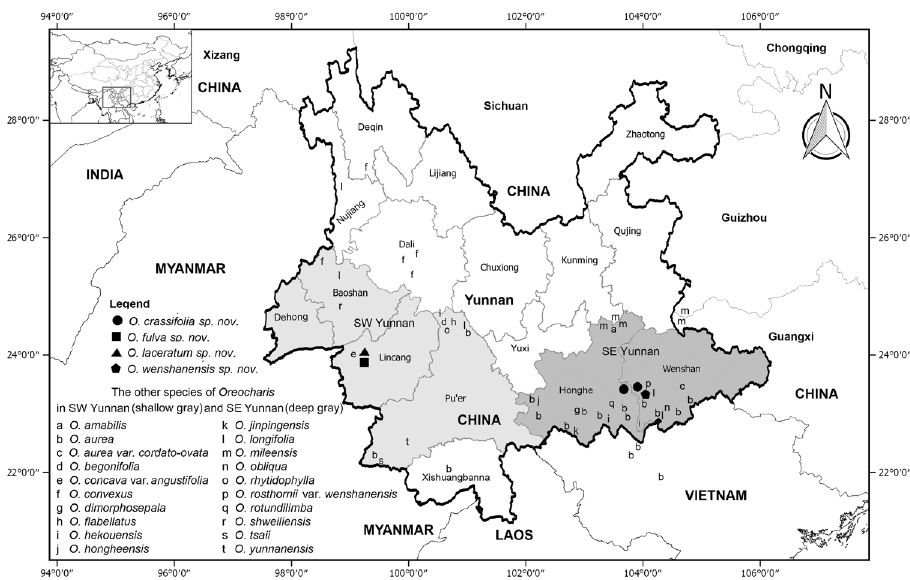
Figure 1. The localities of the four new species and the other species of Oreocharis s.l. from SW Yunnan and SE Yunnan in SW China. The districts are shown in Yunnan province, SW